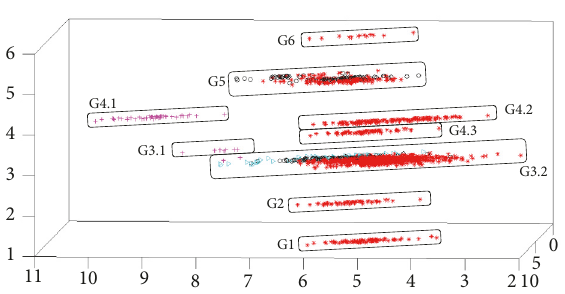
Figure 6: HUEP: CMLHL + partitional clustering ( k =6) + Psychic - Democracy